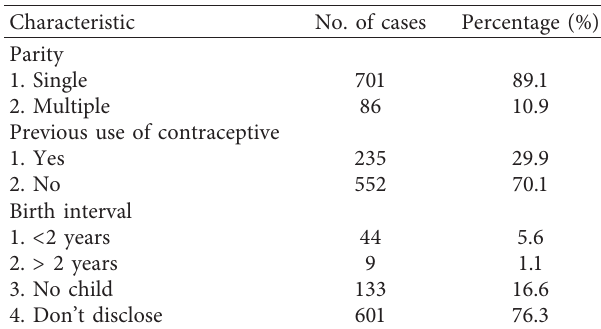
Table 2: Obstetrics and medical-related characteristics of